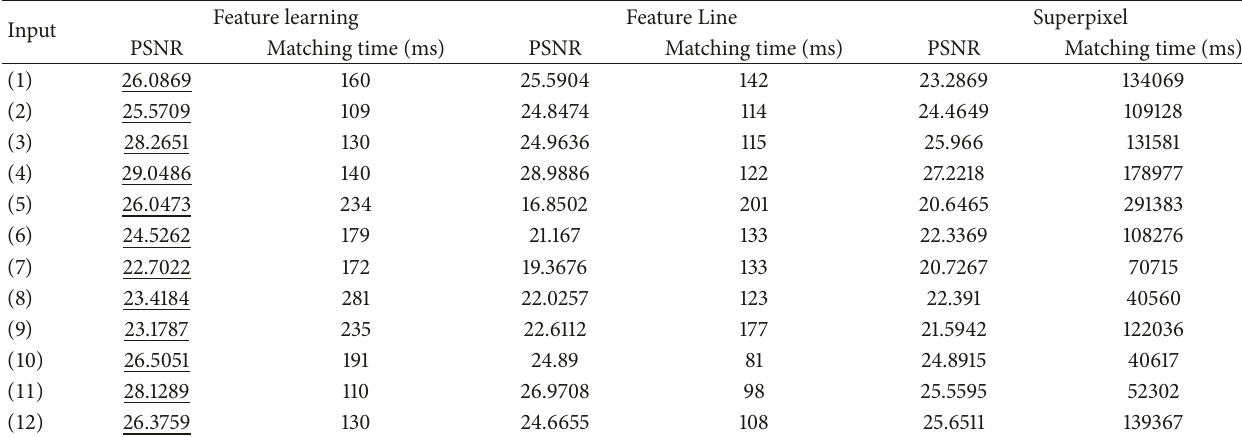
Table 2: The comparisons of PSNR and matching time when using different methods for matching process in